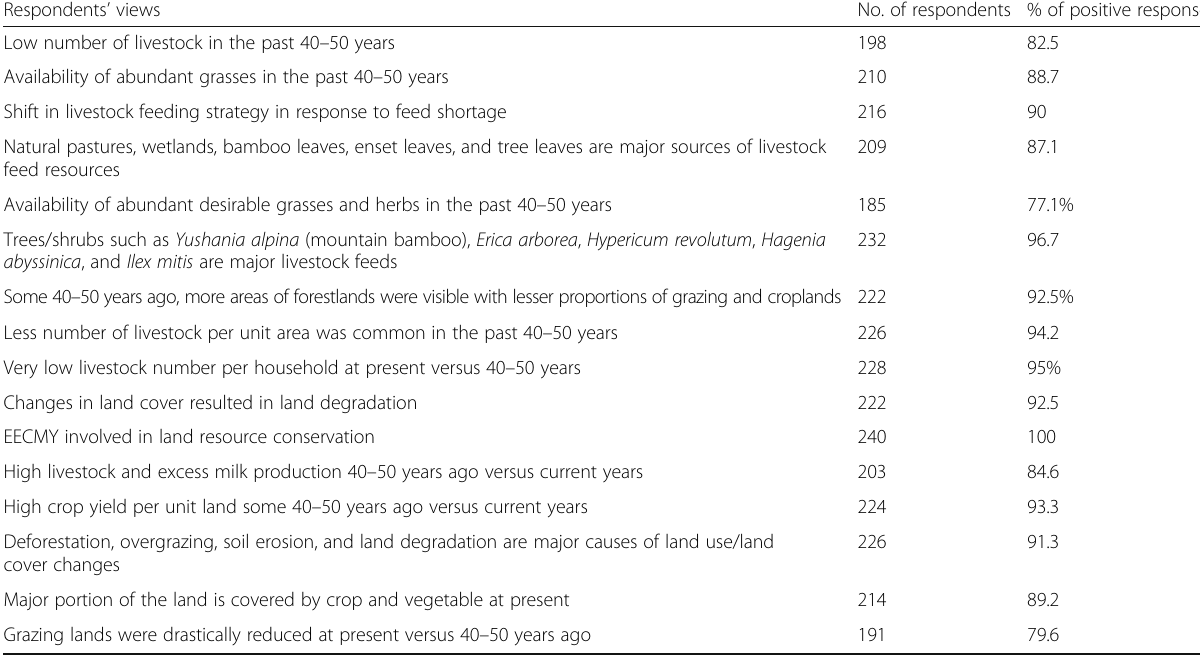
Table 2 Community ’ s perception of land use/land cover changes comparison 40 – 50 years ago versus the present situation in Sidama, South